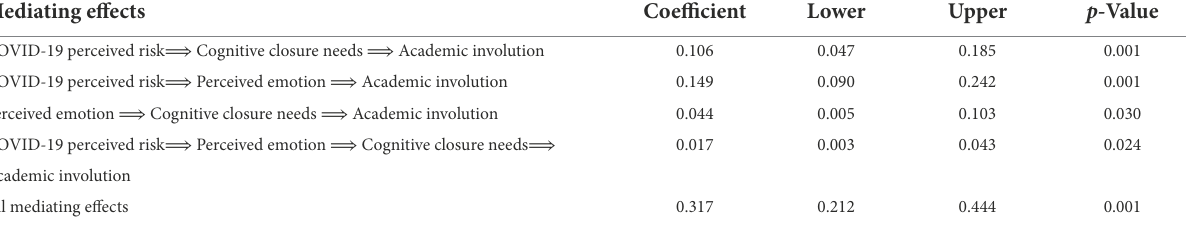
TABLE 4 Mediating effect results and tests of path analysis with latent